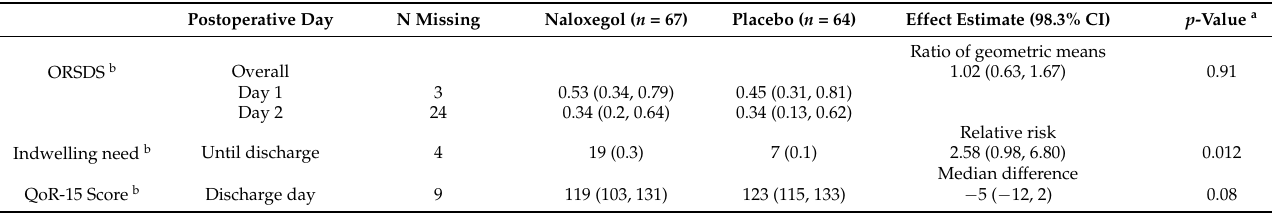
Table 3. Treatment effect on secondary